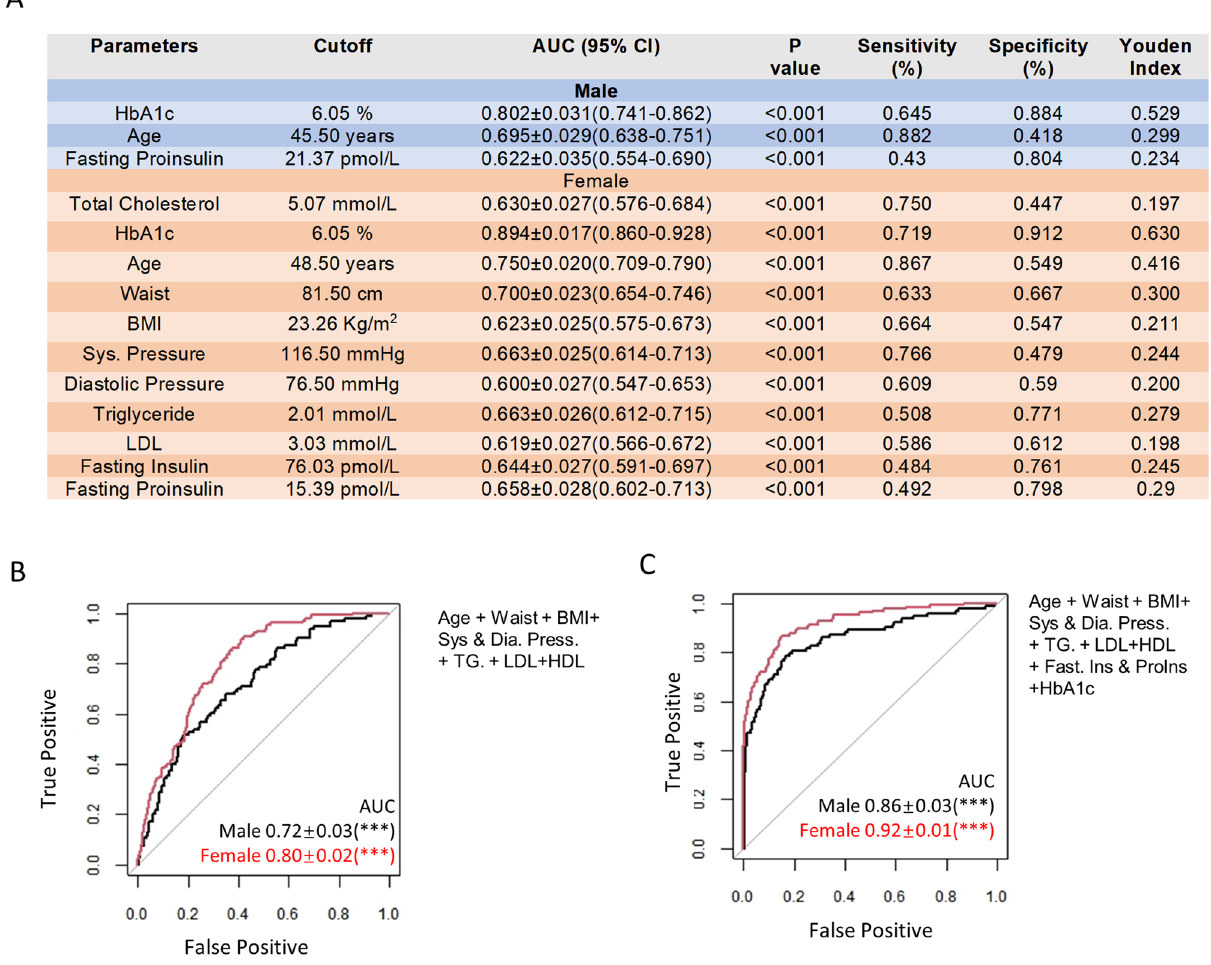
Figure 5. Sex-difference in the cutoffs of the predicting parameters individually or in combination. ( A ) The cutoffs of 3 parameters in men and 11 parameters in women having significant (P < 0.05) prediction power (ROC-AUC values > 0.6). A comprehensive comparison between men and women on the cutoffs, ROC-AUC values, sensitivity, specificity, and Youden Index is shown in Table S4. ( B ) A combination of age, waist, BMI, systolic and diastolic blood pressure, triglyceride, LDL, and HDL in T2D prediction by ROC analysis. ( C ) A combination of fasting insulin and proinsulin and HbA1c with parameters in ( C ) for T2D prediction. AUC area under the curve, ***P <